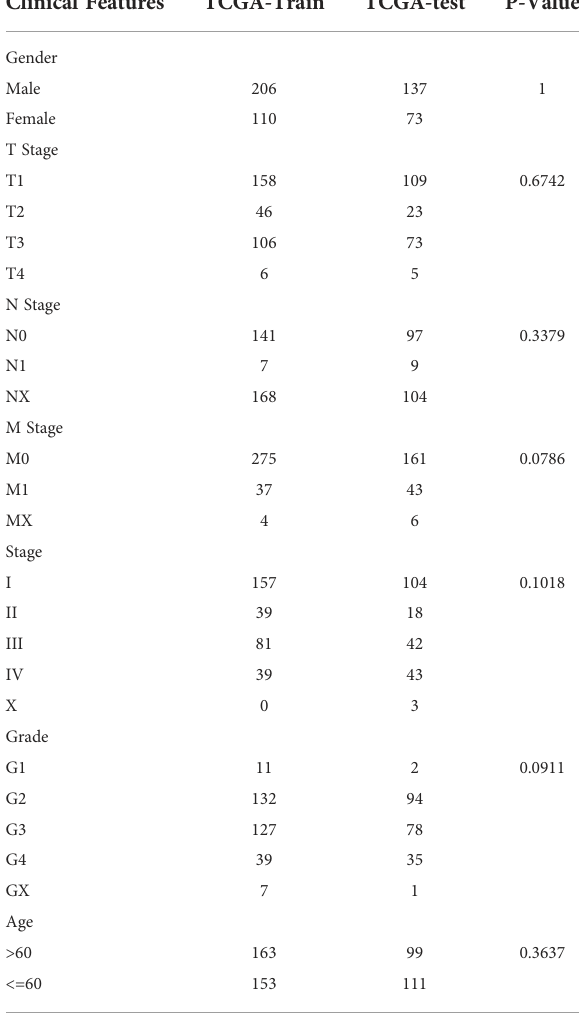
TABLE 2 Clinical information of TCGA training set and validation set samples. Clinical